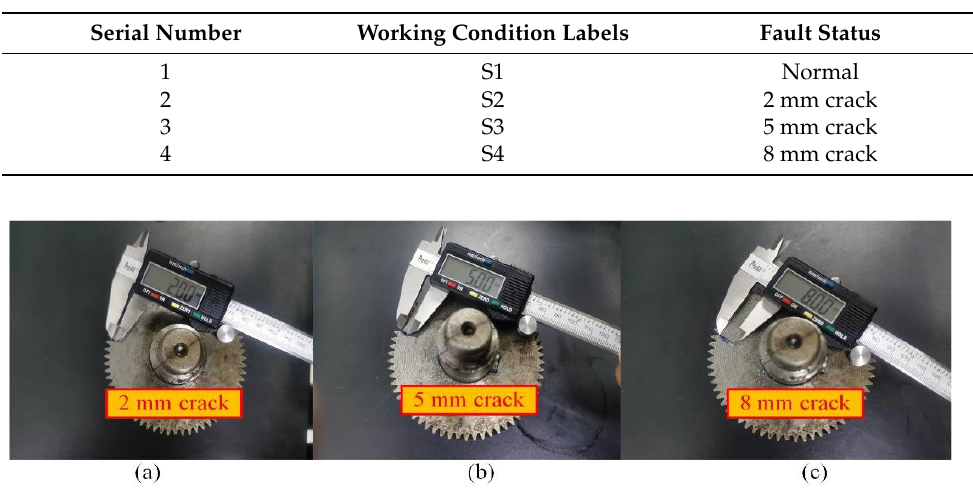
Table 1. Fault presetting modes for gearheads.